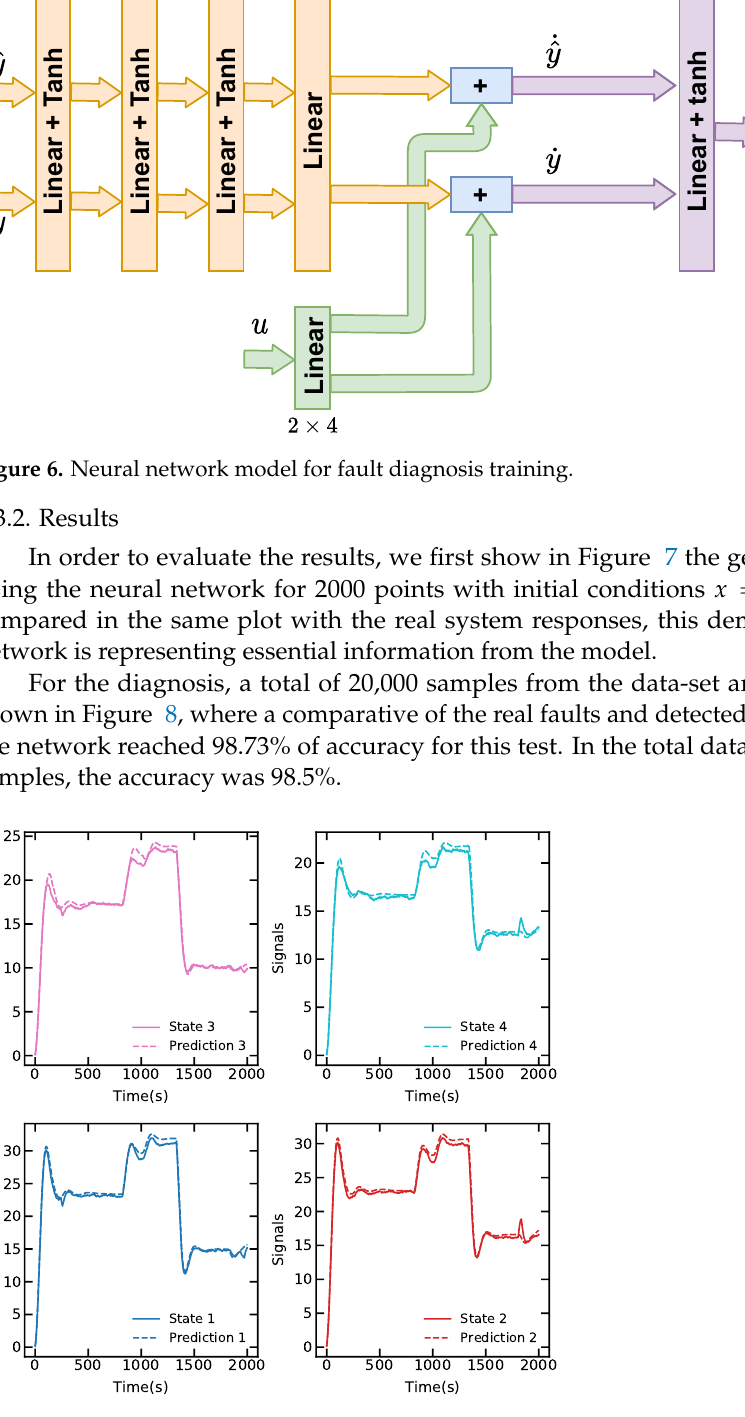
Figure 7. First stage. Continuous line: true dynamics, dotted line: learned